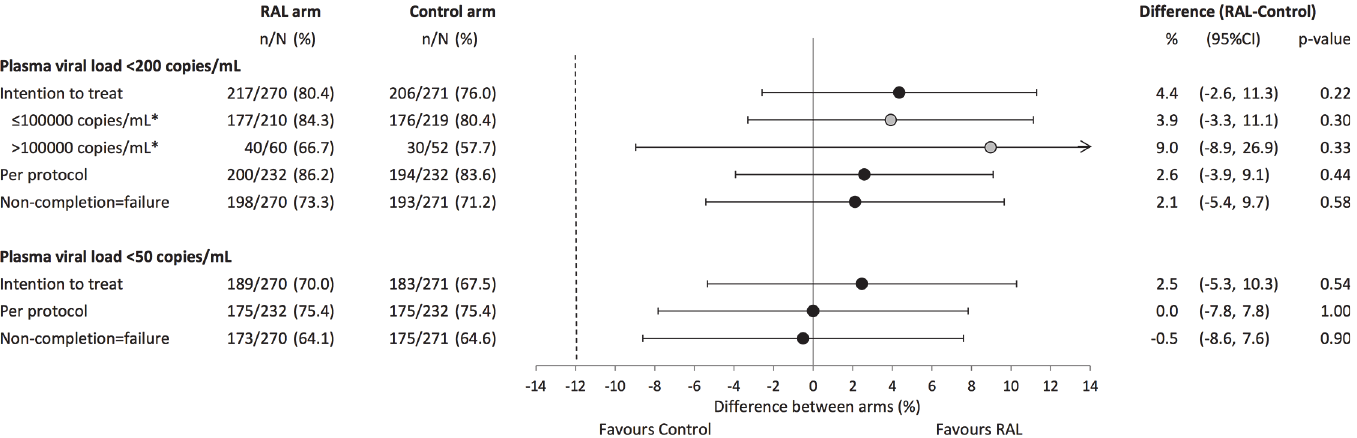
Fig 2. Virologic response at Week 96, by randomised arm, study population and screening strata. RAL = lopinavir/ritonavir+raltegravir Control = lopinavir/ritonavir+2/3 nucleoside/nucleotide reverse transcriptase inhibitors. * grey circle = screening plasma viral load strata, P interaction = 0.81, bars are 95%confidence intervals (CI).